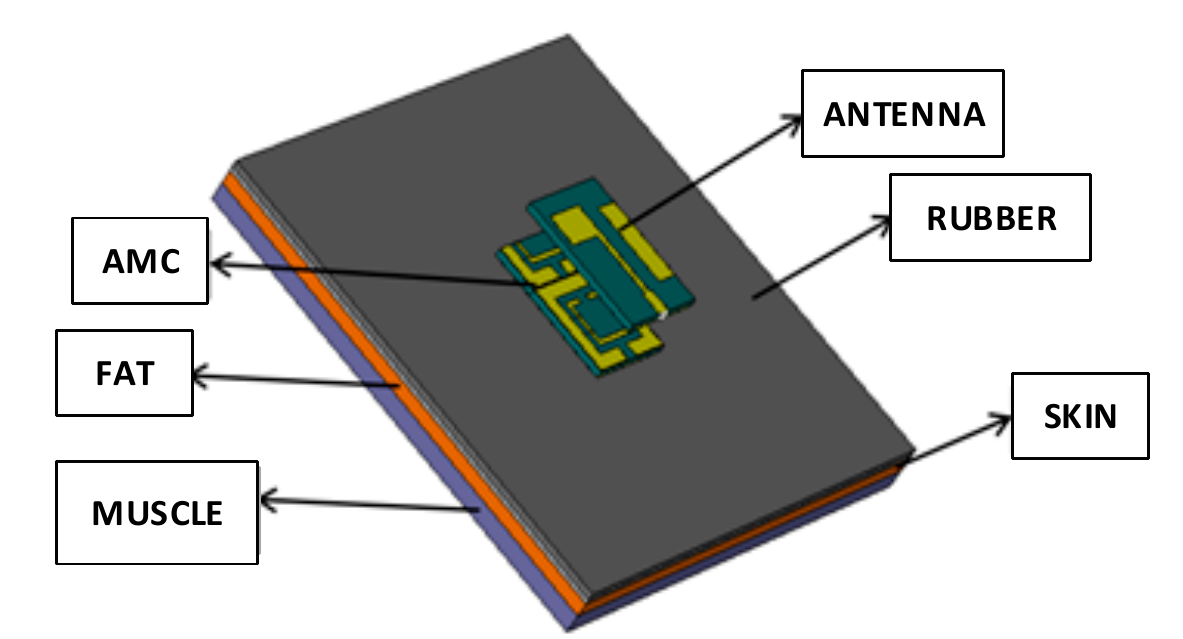
Figure 26. Three-dimensional layer model of human tissues with the AMC-backed antenna. Figure 27 depicts the simulated and measured reflection coefficients of the AMC- backed antenna on the human phantom. Simulations on the human phantom revealed that Table 4. Properties of different human tissue layers [19]. the AMC-backed antenna had a reflection coefficient close to − 14 dB at 2.45 GHz for both simulated and measured outcomes, and close to − 16 dB at 5.8 GHz for both simulated and measured results. This implies that the simulated and measured plots can be regarded as a good match.